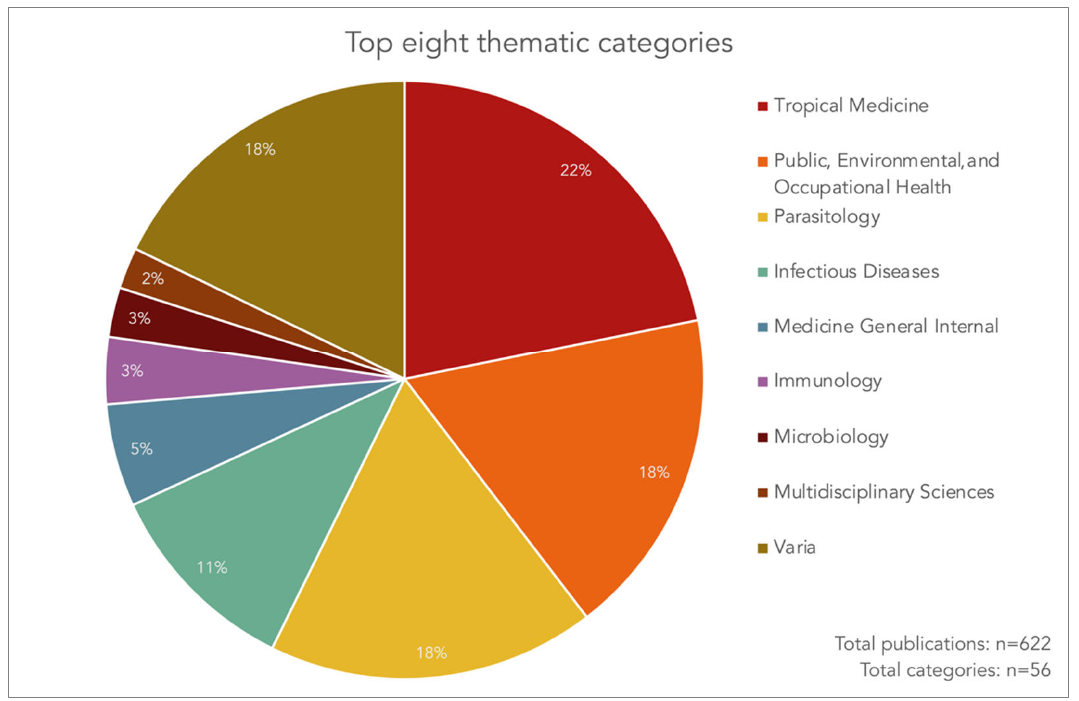
Figure 4. The top eight Web of Science categories for Marcel Tanner’s publications between 1978 and 2021 (source: Web of Science Core Collection, search performed on 3 August 2022).